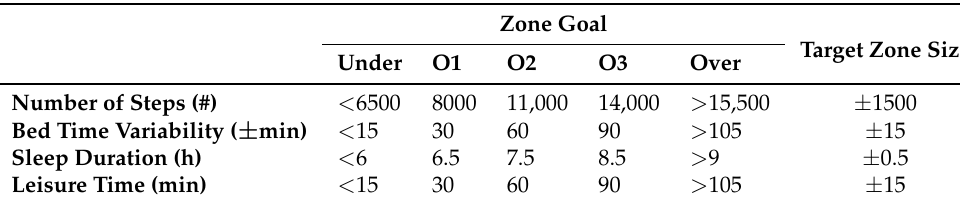
Table 2. Definitions of target zones of behaviors for each experiment.